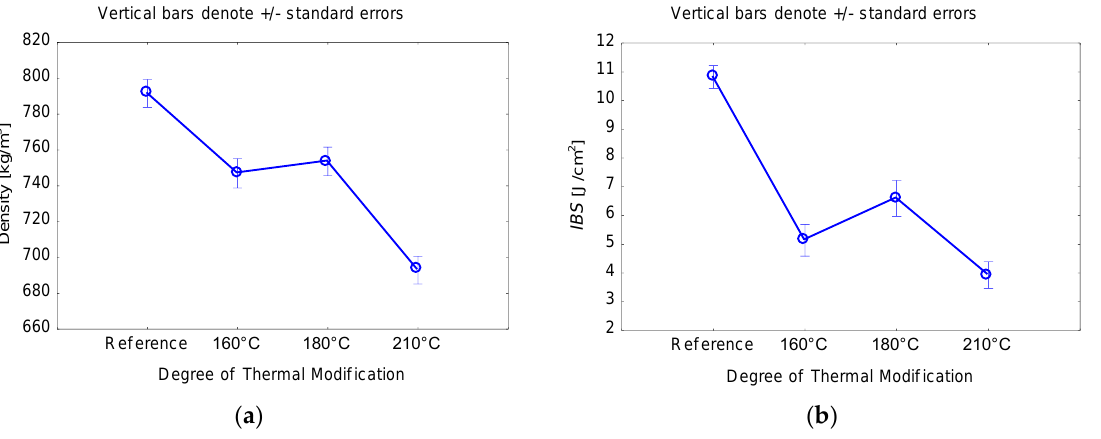
Figure 2. ( a ) Influence of thermal modification on density; ( b ) influence of thermal modification on impact bending strength.